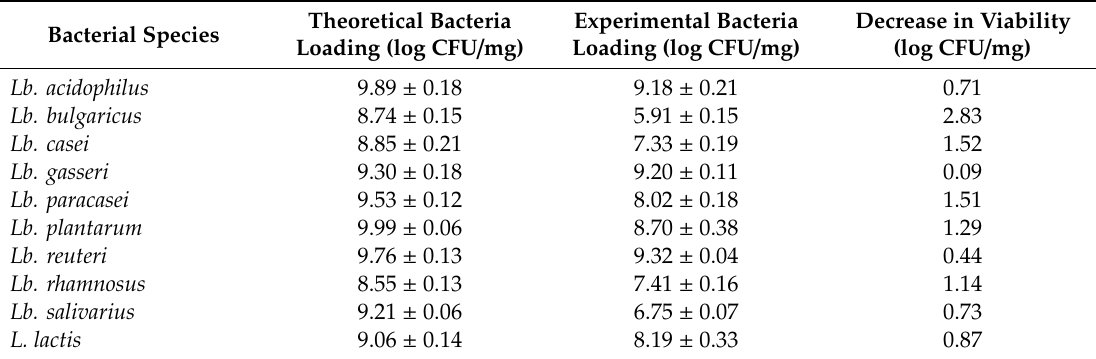
Table 4. Viability of the lactic acid bacteria in PEO solution before and after their incorporation into